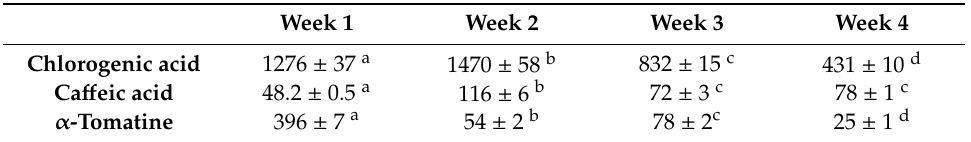
Table 2. Concentrations of chlorogenic acid, ca ff eic acid and α -tomatine in Gs administered in the four weeks of gavage.